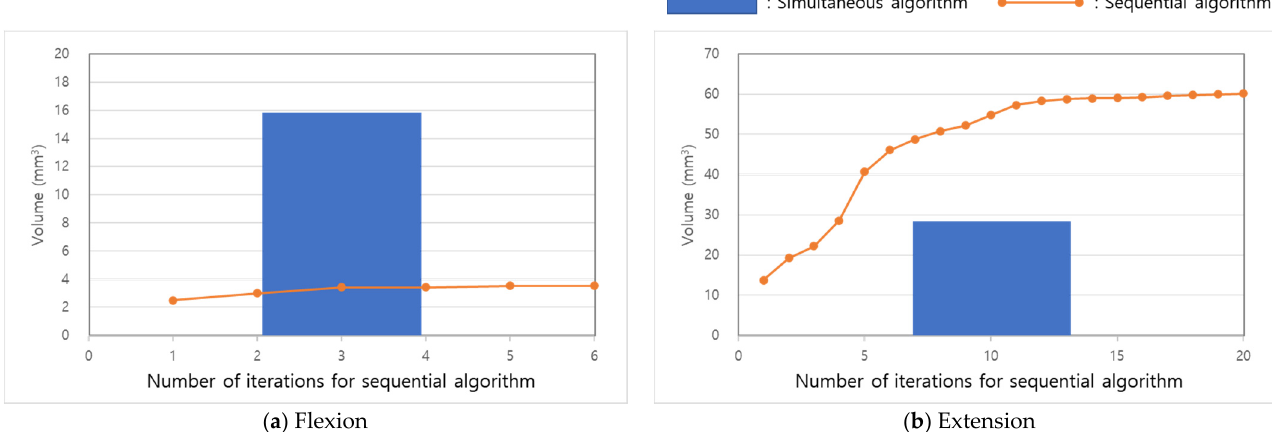
Figure 7. Bone formation using simultaneous and sequential algorithms during ( a ) flexion and ( b ) extension.